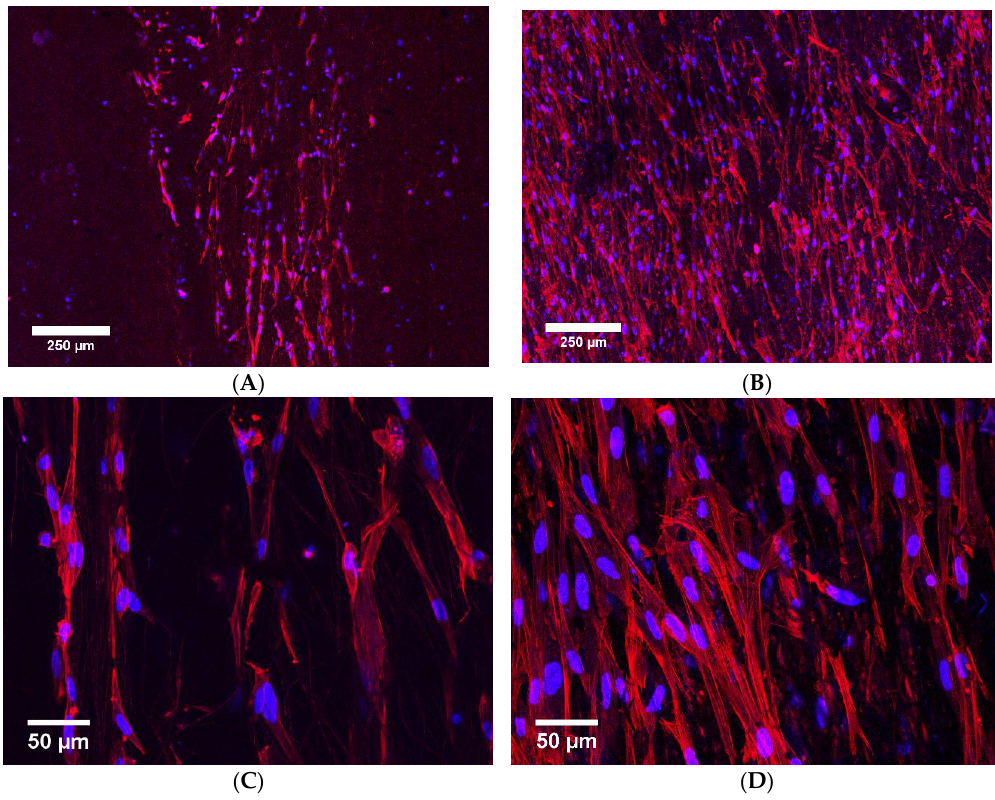
Figure 7. Fibroblast cells after 7 days on conductive scaffolds of PPy-coated PCL. Plasma treatment (S2) provided a better surface for the cells to attach to, compared to samples without plasma treatment (S1). This is evidenced by the cells in images B and D, which have approximately twice the cells in images A and C. ( A ) Cells on S1 at low magnification; ( B ) Cells on S2 at low magnification; ( C ) Cells on S1 at high magnification; ( D ) Cells on S2 at high magnification.